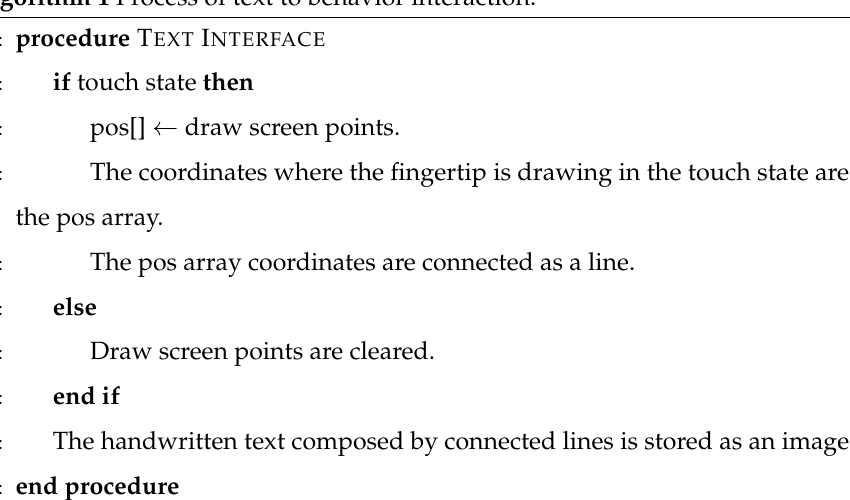
Algorithm 1 Process of text to behavior interaction.